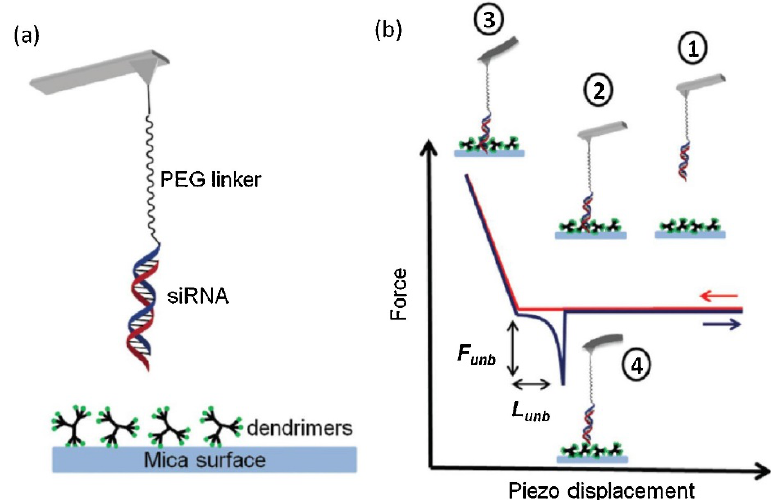
Figure 7. ( a ) Scheme of the tip functionalization and dendrimer adsorption on mica. ( b ) Main steps of a force curve depicting a molecular recognition (specific) event. 1 (cid:13) . Tip far from the surface. 2 (cid:13) . Initial tip–surface contact (approaching). 3 (cid:13) . Tip–surface repulsive region. 4 (cid:13) . Molecular recognition unbinding force. Reproduced with permission from [135].